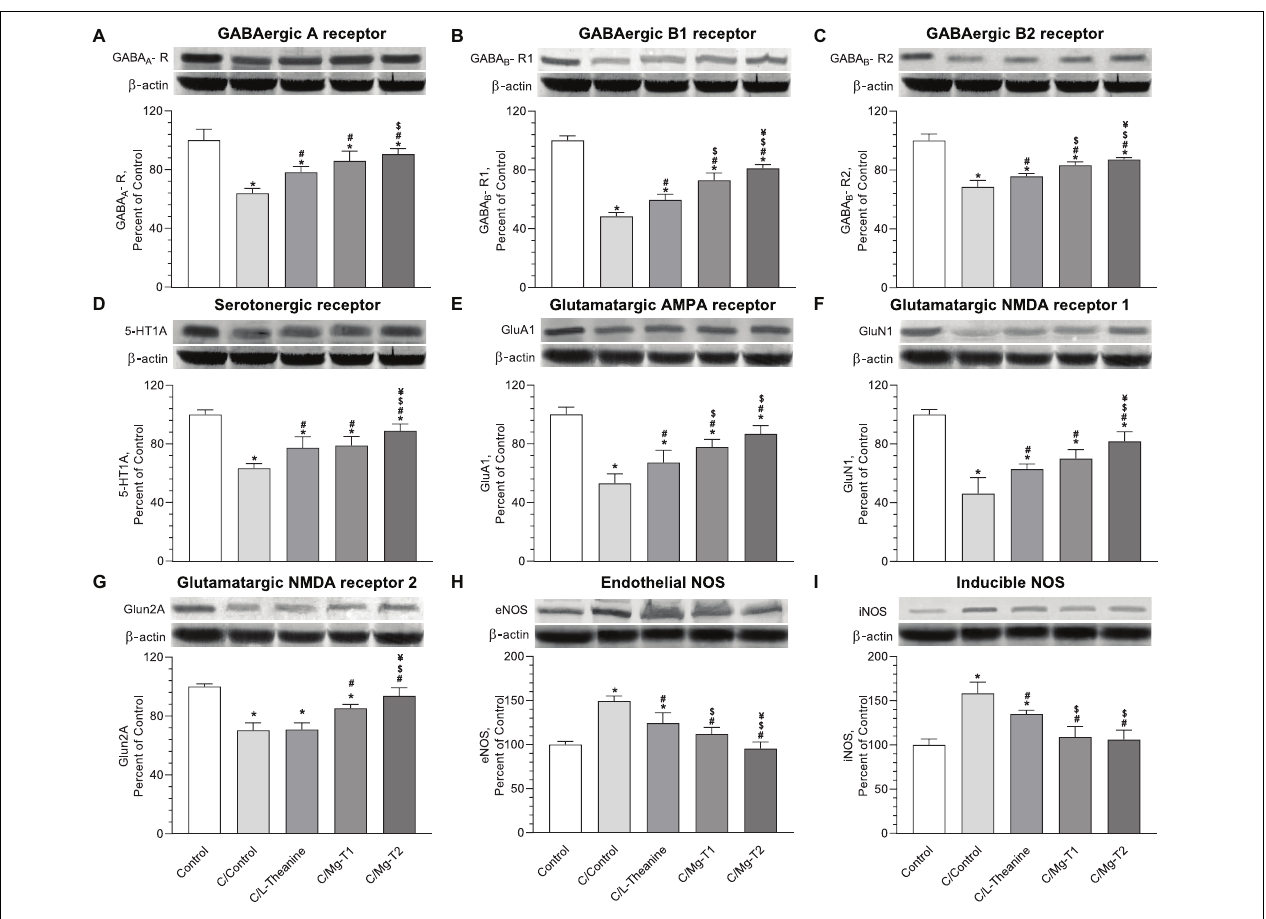
FIGURE 3 | L -Theanine and Mg- L -theanine compounds reverse caffeine’s effect on inhibitory and glutamate receptors. Western blot results of GABAergic receptors GABA A -R (A) , GABA B -R1 (B) , GABA B -R2 (C) , serotonergic receptor 5-HT 1 A (D) , glutamatergic receptors GluA1 (E) , GluN1 (F) , GluN2A (G) , and nitric oxide synthases, eNOS (H) , and iNOS (I) . All groups normalized according to housekeeping protein β -actin (three β -actin blots were performed for GABAergic